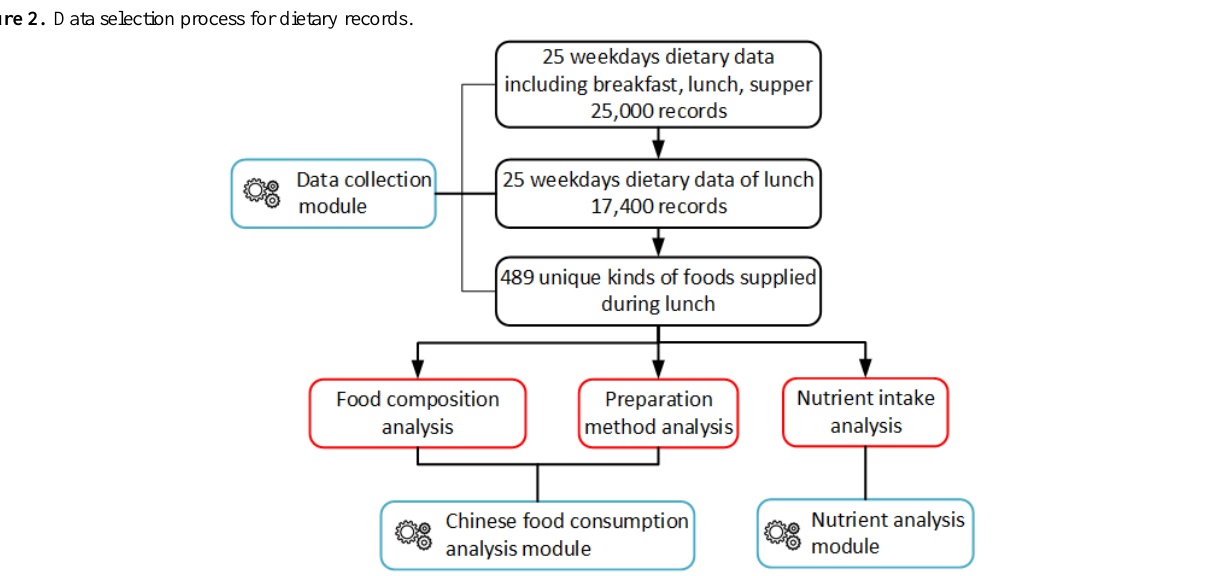
Figure 2. Data selection process for dietary